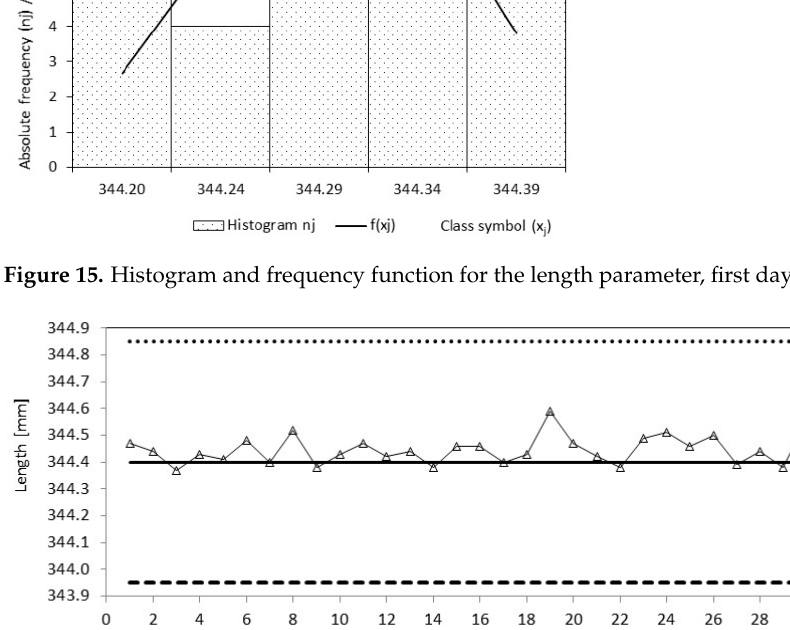
Figure 15. Histogram and frequency function for the length parameter, first day [20].